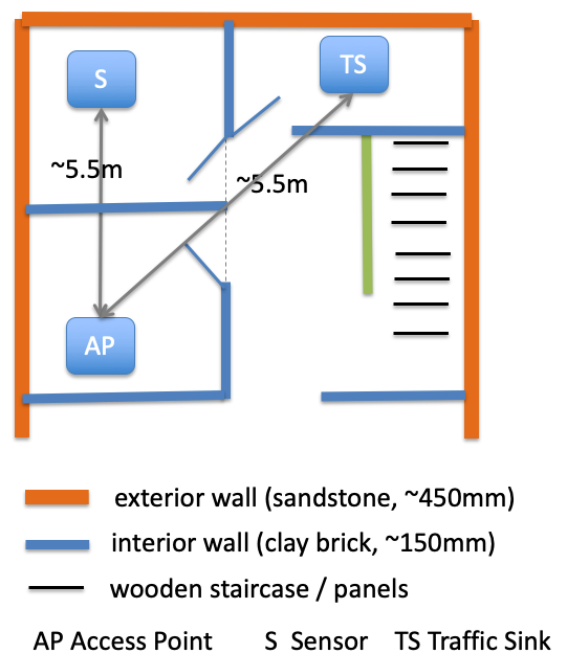
Figure 2. Schematic of the testbed showing physical